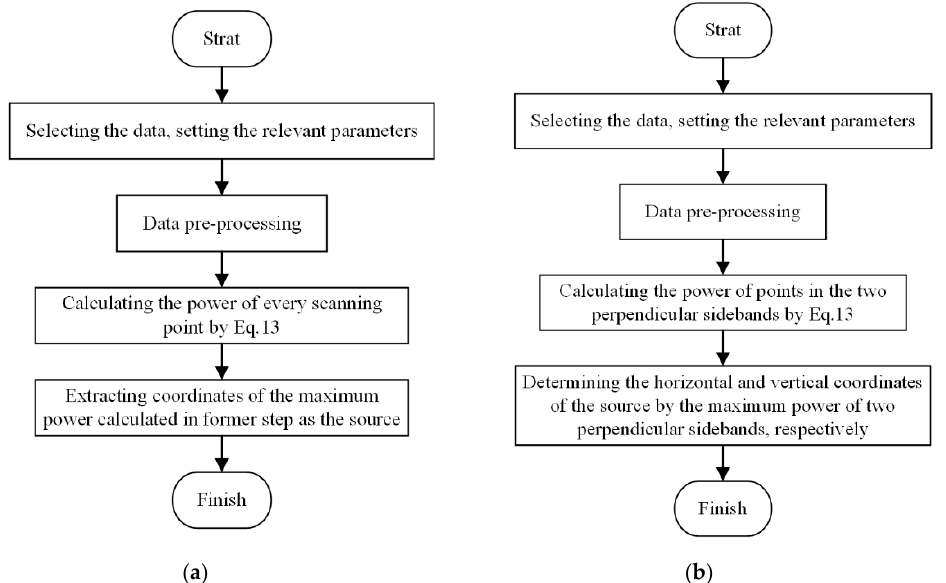
Figure 8. The flowcharts of the Bartlett beamforming method (BBM) and fast Bartlett beamforming